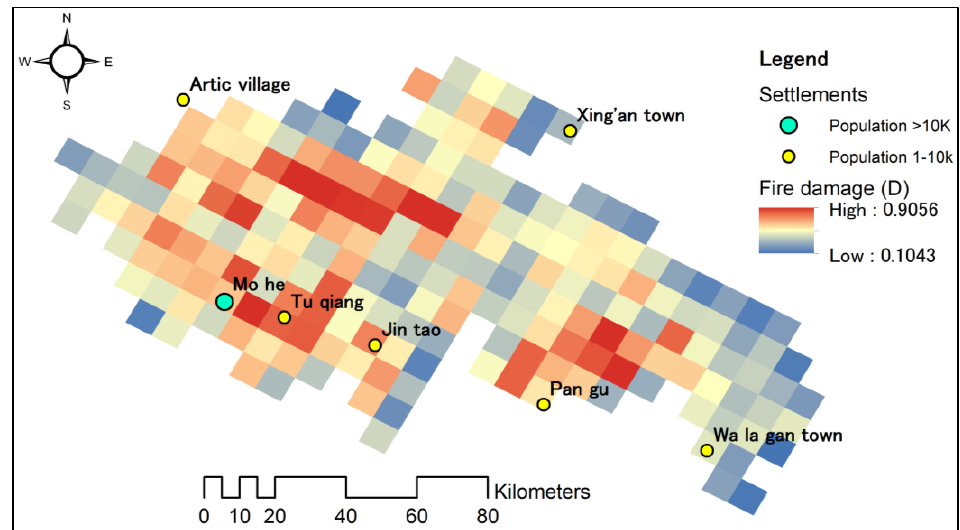
Figure 2. Fire damage map of the study area for the Daxing’anling fire event with fire damage values obtained using Equation (1).